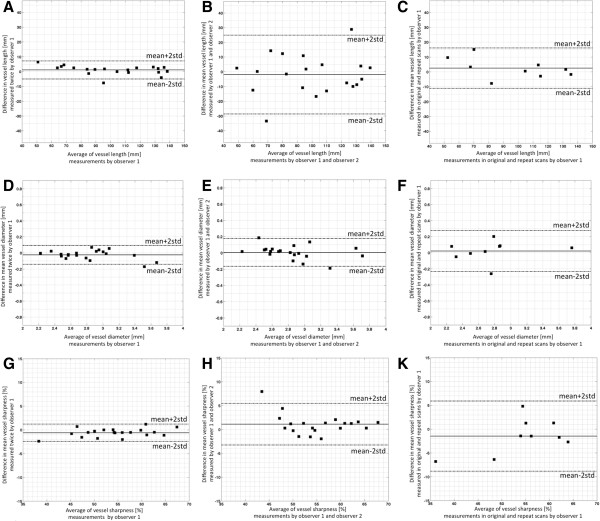
Repeatability and reproducibility of vessel length, mean diameter, mean sharpness measurements with bSSFP sequence. Bland-Altman plot shows good (A) intra-observer (r = 0.994), (B) inter-observer (r = 0.894), and (C) intra-class (r = 0.980) agreement between length measurements [mm] with low variability. Bland-Altman plot shows good (D) intra-observer (r = 0.990), (E) inter-observer (r = 0.977), and (F) intra-class (r = 0.959) agreement between mean diameter measurements [mm] with low variability. Bland-Altman plot shows good (G) intra-observer (r = 0.993), (H) inter-observer (r = 0.953), and (K) intra-class (r = 0.932) agreement between mean sharpness measurements [%] with low variability.